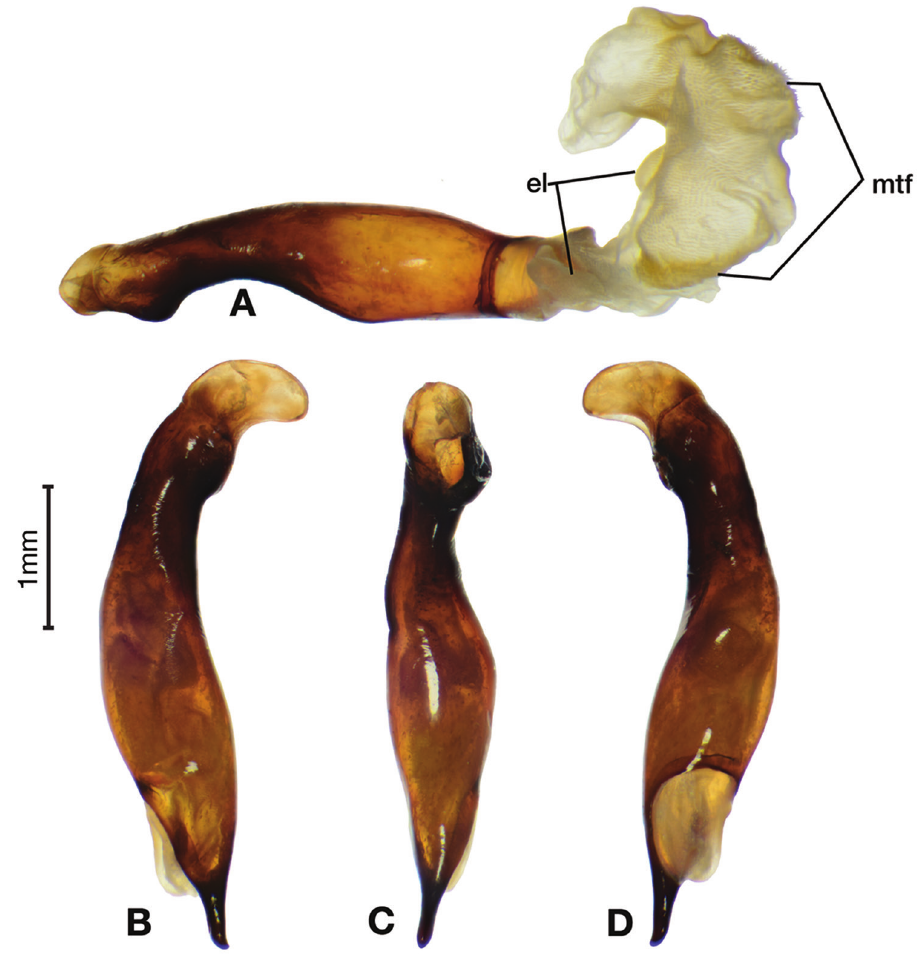
Figure 32. Digital images of male genitalia of C . ( Catascopoides ) horni Jedlička A left lateral aspect en- dophallus everted B right lateral aspect C ventral aspect D left lateral aspect. Legend: el endophallic lobe; mtf microtrichial